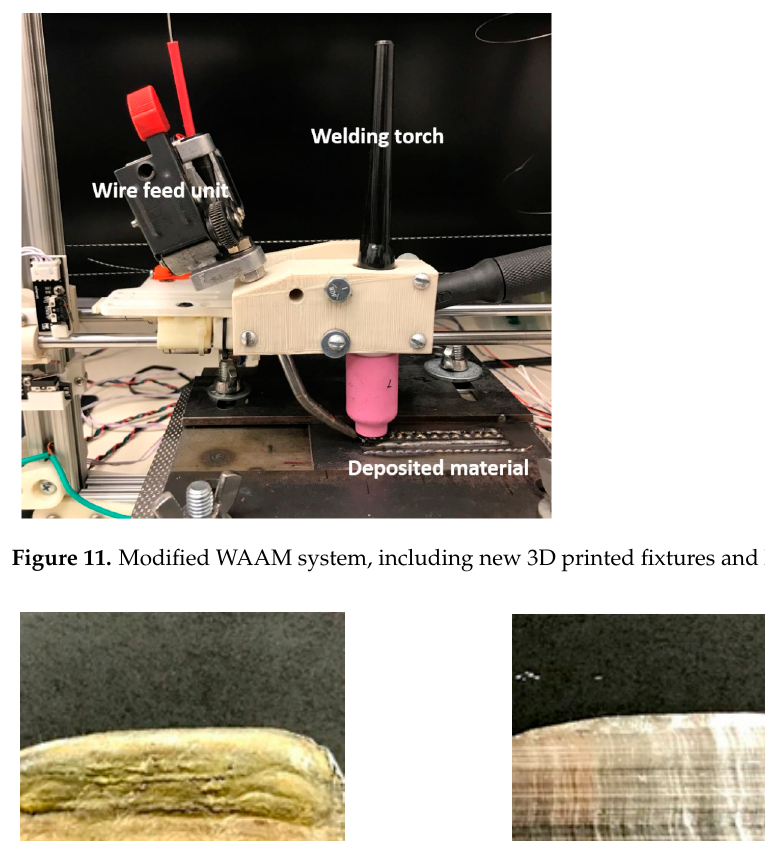
Figure 11. Modified WAAM system, including new 3D printed fixtures and holders.